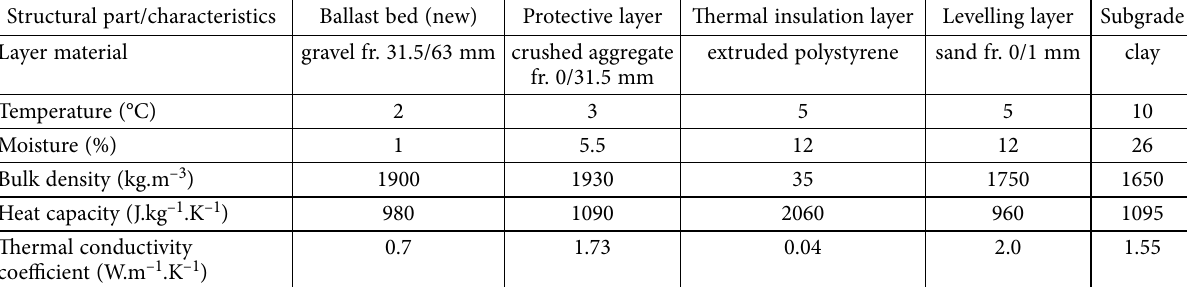
Table 2. Input parameters of numerical modelling – material characteristics